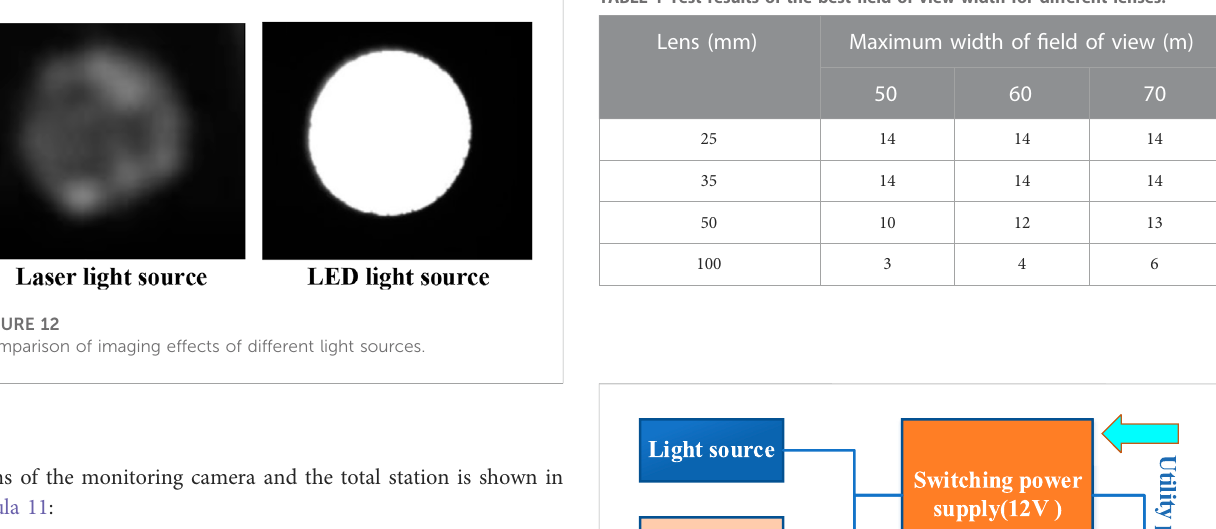
TABLE 1 Test results of the best fi eld of view width for different lenses.